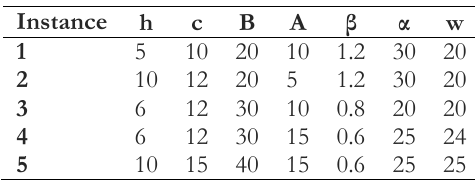
Table 1. Numerical parameters of sample problems in centralized and decentralized scenarios.